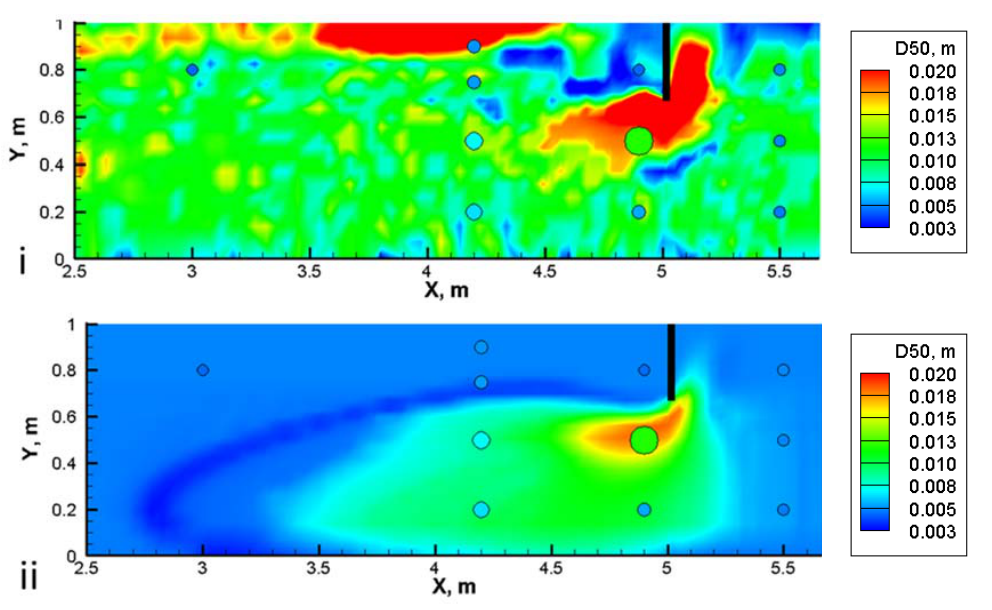
Figure 9. Measured and simulated equilibrium bed levels at Q = 58 L/s (top: measured, i: vR; ii: Wilcock and Crowe formula; iii: combined approach).